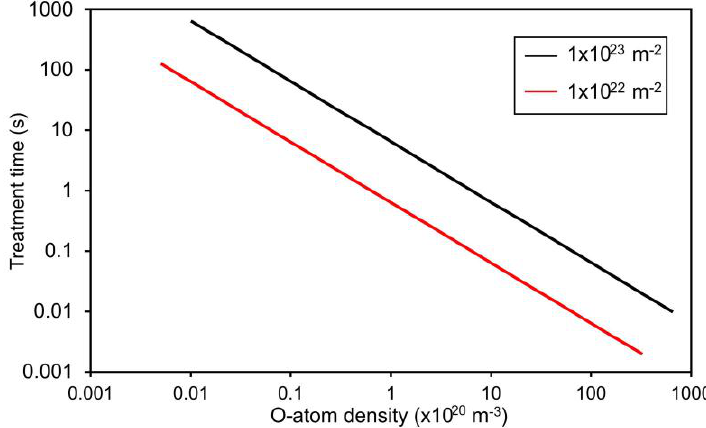
Figure 3. Recommended treatment times for achieving good wettability (~40°) of the acryl-coated polypropylene foils at two O-atom fluences.